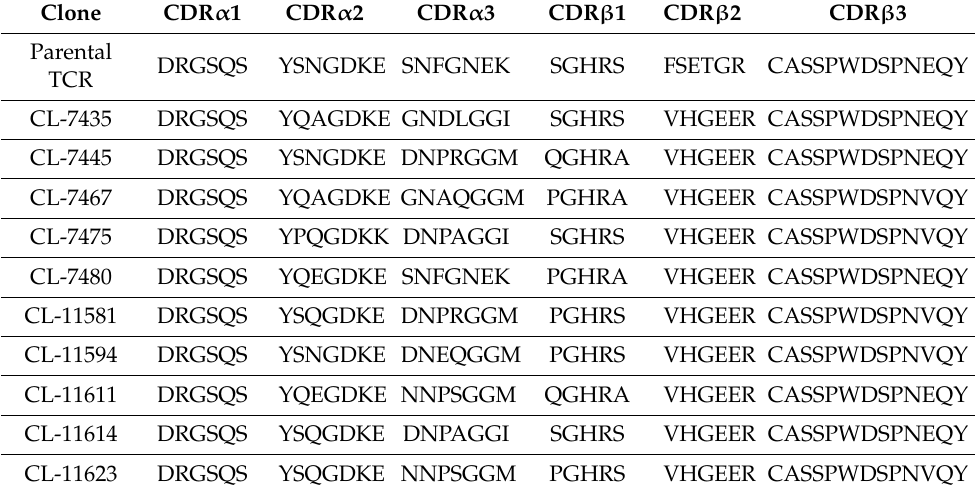
Table 3. CDR sequences of selected TCER candidates from the CDR combinatorial screening in comparison to the wild type CDRs of the parental